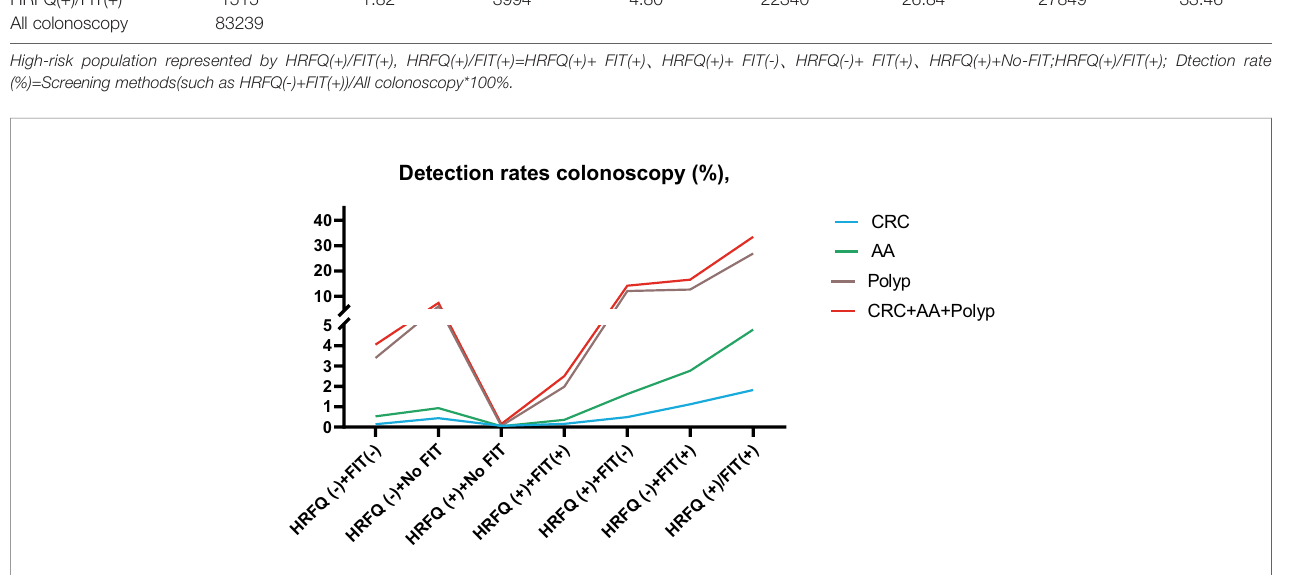
( Table 10 and Figure 8D ) and was 31.75%, 41.29%, 48.44%, and ( Table 10 and Figure 8H ), respectively. Further, the detection rate was higher in central urban areas (48.36%) than in agriculture-related areas (42.33%) ( Table 10 and Figure 8P ), and higher in those with primary school above education level (46.09%) than those with lower education level (41.05%) ( Table 10 and Figure 8T ). In addition, the detection rate of CRC, AA, polyps, and intestinal disease was no higher in manual workers than in those engaged in mental work ( Table 10 and Figures 8I-L ). CRC detection rates were